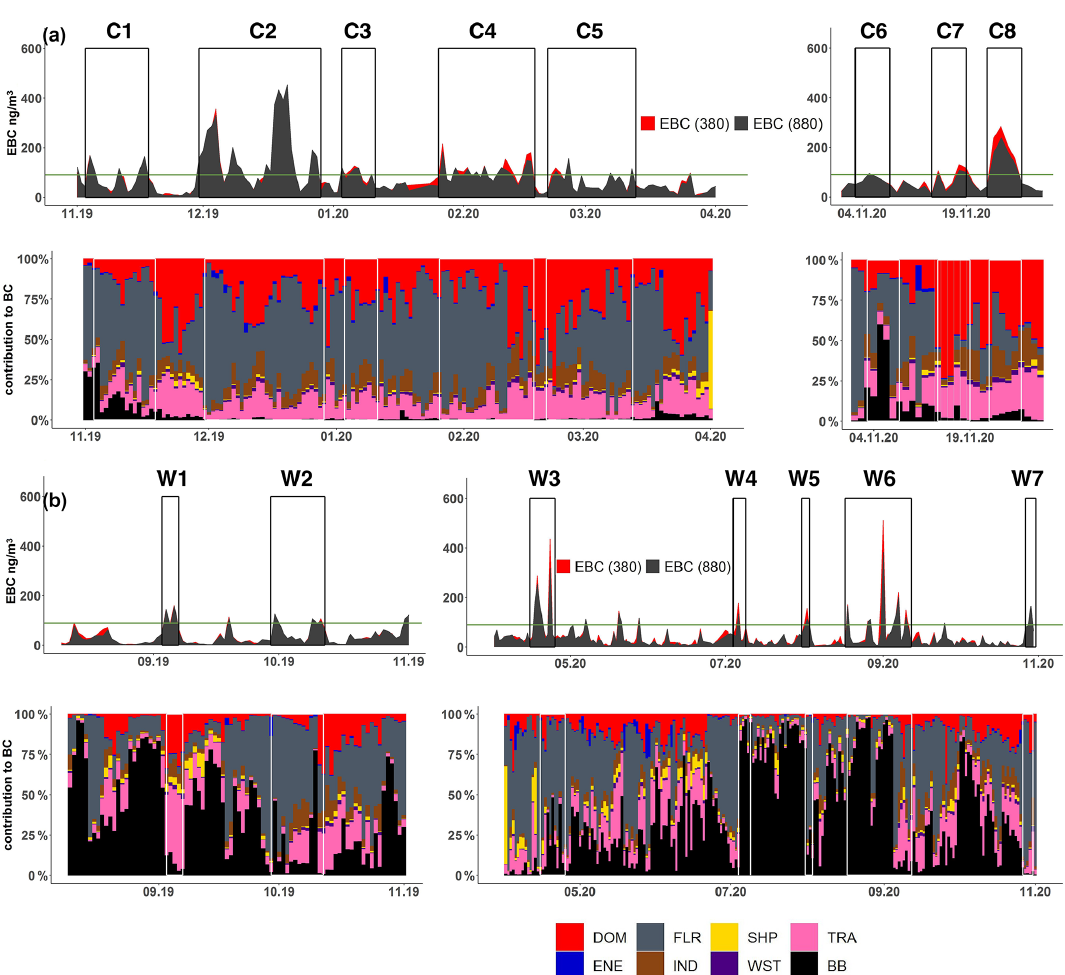
Figure 5. The 24h median EBC concentrations measured at 880nm (black) and 370nm (red), as well as source contributions to surface BC from anthropogenic (DOM, ENE, FLR, IND, SHP, WST, TRA) and BB sources for (a) the cold and (b) the warm period. Pollution episodes were composed from the periodically repeated events of high EBC concentration. The straight green line indicates the pollution level of the 80th percentile.